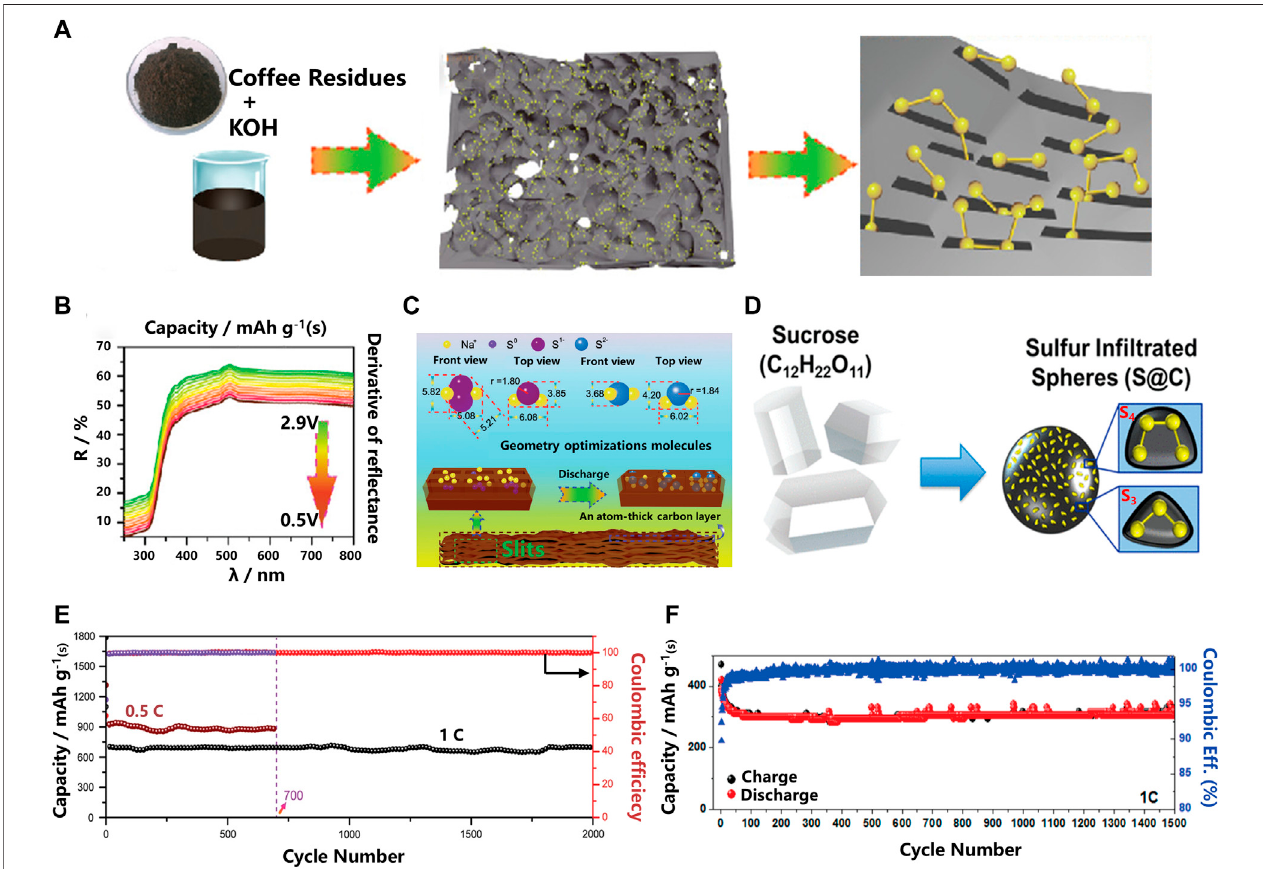
FIGURE 2 | (A) Schematic illustration of the synthesis procedure for the microporous carbon and sulfur composite with small sulfur molecules con fi ned in the carbon micropores; (B) In situ UV-vis spectra; (C) Schematic illustration of the reaction mechanism of the ACC-40S cathode for RT Na – S batteries; (D) Schematic representation of the material processing steps of using sucrose (sugar) to produce microporous sodium sulfur battery cathodes; (E) Cycle performances of the ACC- 40S electrode at 0.5 and 1 C for 700 and 2000 cycles, respectively; (F) Prolonged cycling performance of 1,500 cycles at 1C of S@C (Carter, et al., 2017; Guo, et al.,